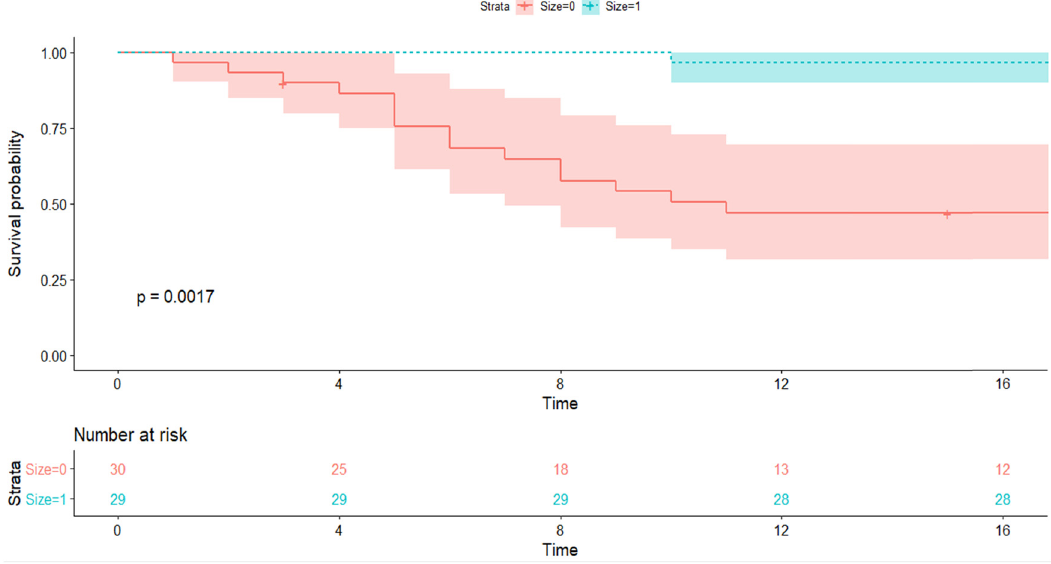
Figure 4: Unconditional survivor function estimates for bigger and smaller